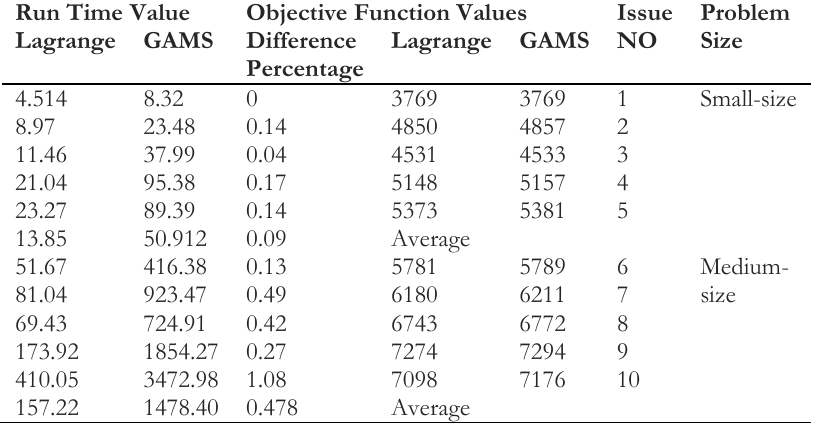
Table 1. Lagrange objective function values in small and medium-size problems.